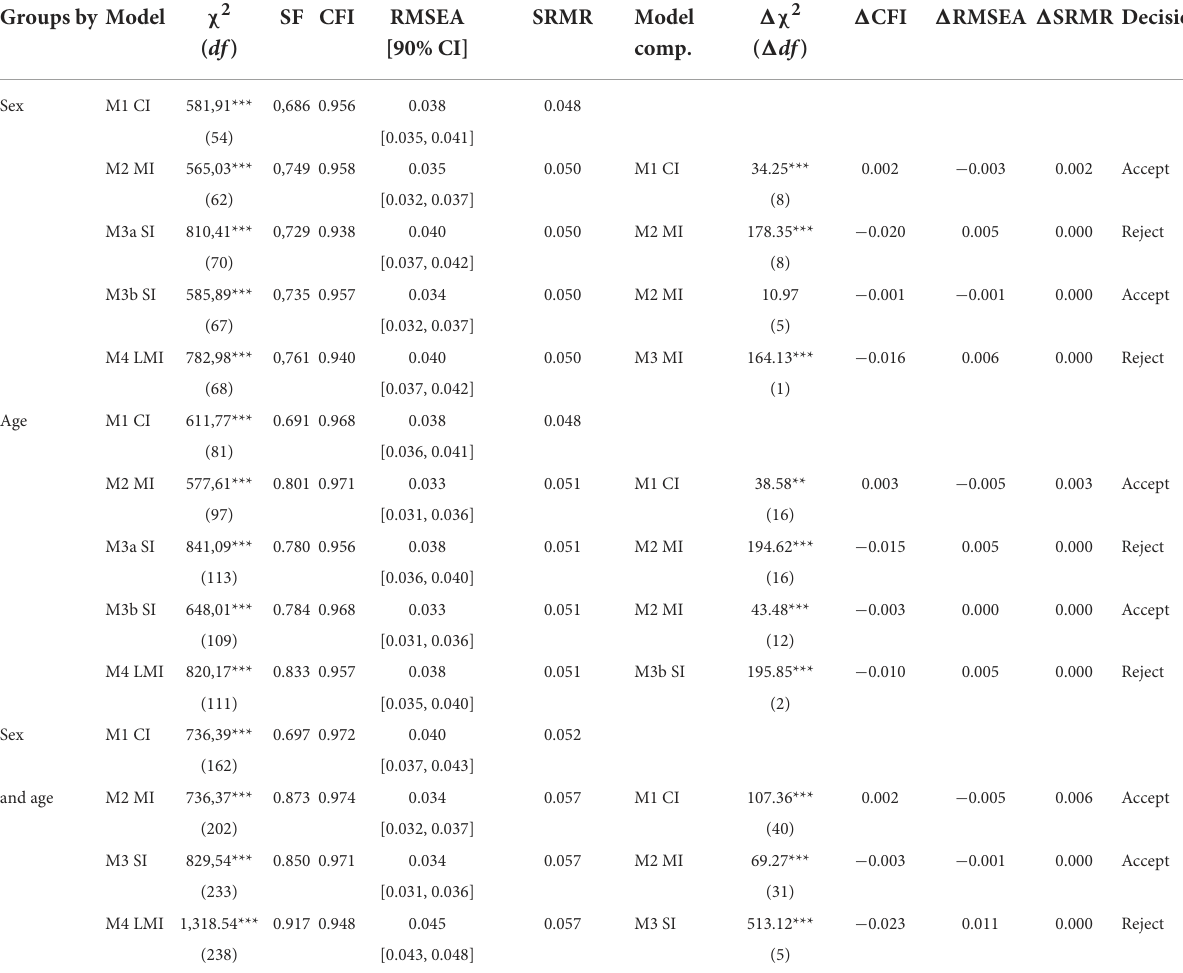
TABLE 3 Measurements of the invariance of the Social Media Disorder Scale. Groups by